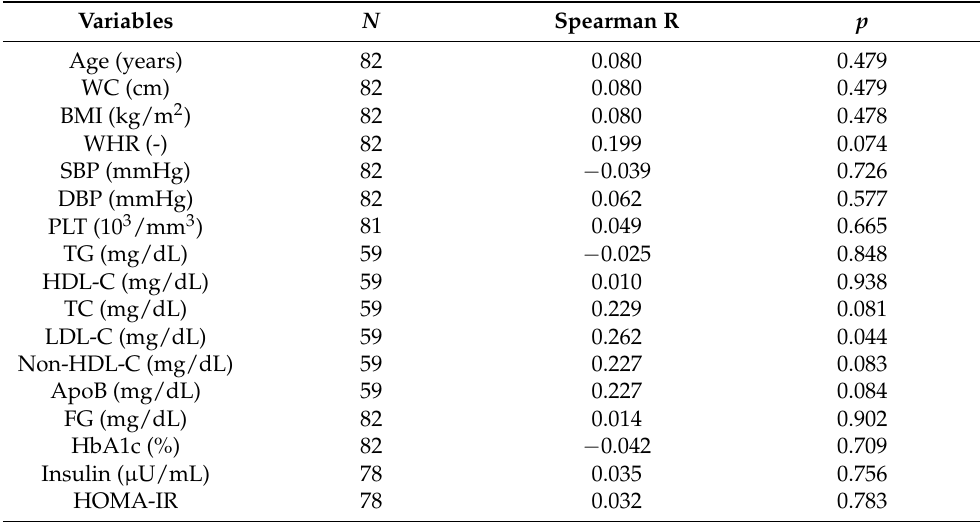
Table 4. Correlation (Spearman R) of 11-dehydro-TXB2 with anthropometric, blood pressure, and laboratory